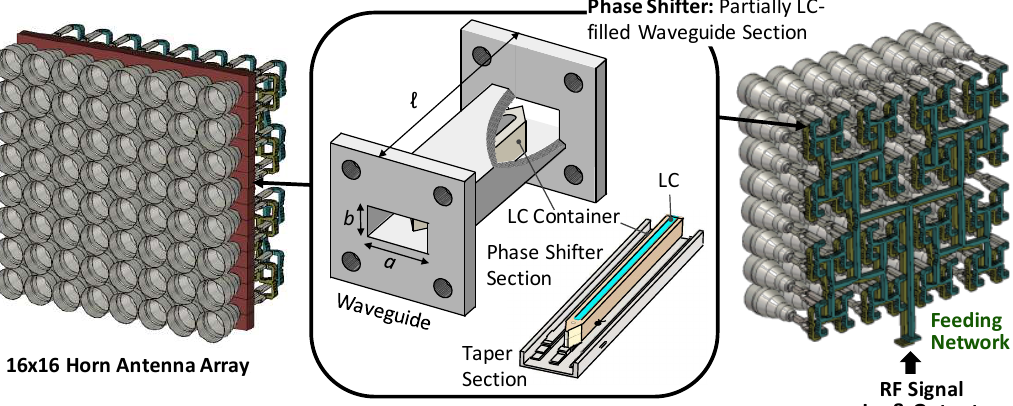
Figure 14. Example of a 16 × 16 horn antenna array for a GEostationary Orbit (GEO) relay satellite. Beam-steering can be achieved by a plug-in solution of a partially LC-filled waveguide phase shifter ( middle ) between horns ( left ) and the feeding network ( right ). At both ends of the phase shifter section, there is a taper section to reduce reflections.